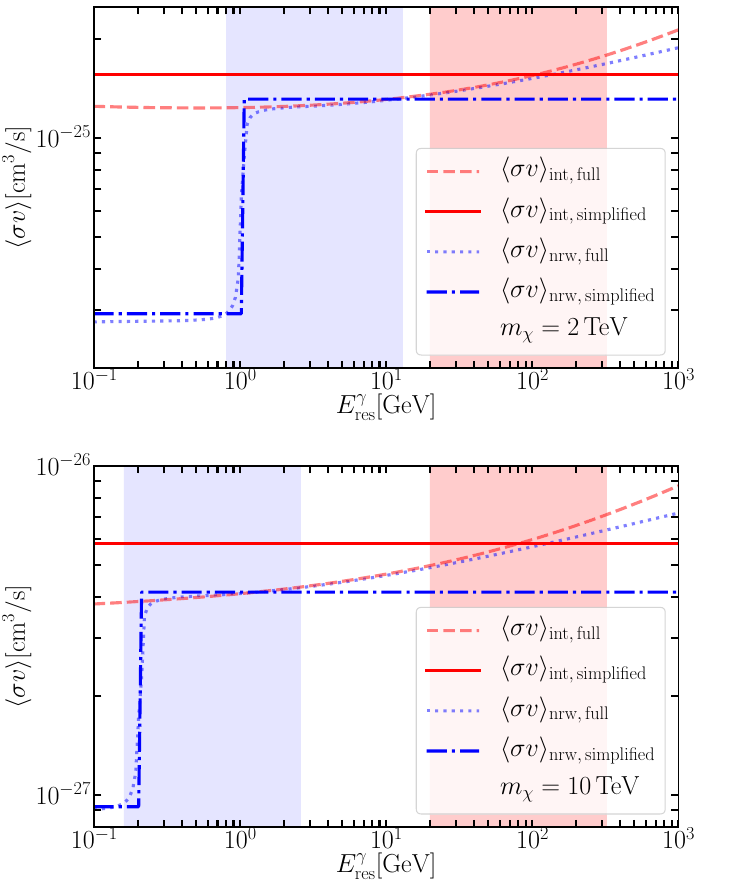
Figure 5 . Same as figure 4 but in the double-logarithmic (“simplified”) approximation. For comparison the complete (“full”) NLL’ results of figure 4 are also included (dimmer dashed and dotted lines). Top: m χ = 2 TeV. Bottom: m χ = 10